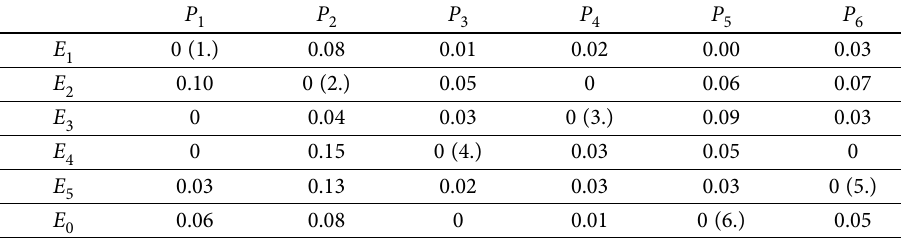
Table 9. Aggregated results with the IOWAD operator (1)